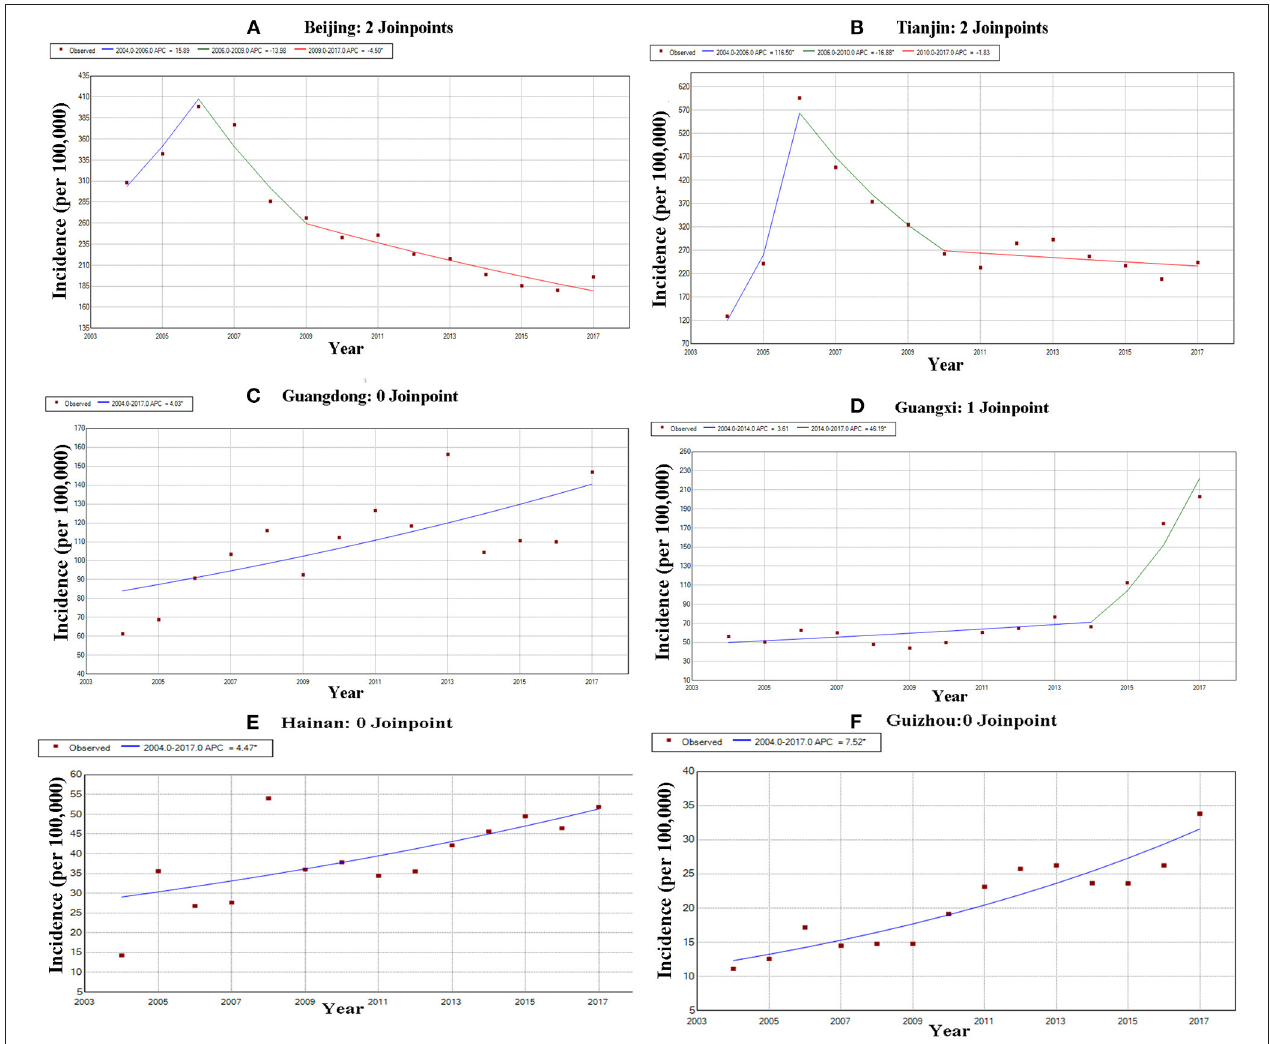
FIGURE 5 | The trends of other infectious diarrhea in hotspots. (A) The Joinpoint analysis of OID in Beijing from 2004 to 2017. (B) The Joinpoint analysis of OID in Tianjin from 2004 to 2017. (C) The Joinpoint analysis of OID in Guangdong from 2004 to 2017. (D) The Joinpoint analysis of OID in Guangxi from 2004 to 2017. (E) The Joinpoint analysis of OID in Hainan from 2004 to 2017. (F) The Joinpoint analysis of OID in Guizhou from 2004 to 2017.